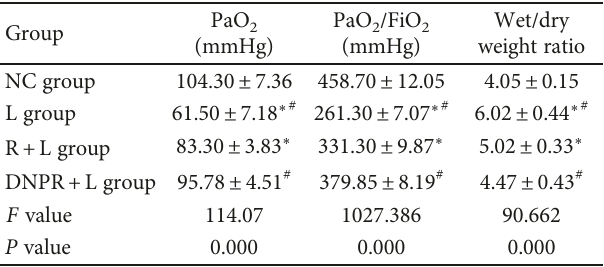
Table 1: E ff ects of LPS and LPS/CCR2 antagonist interventions on PaO , PaO /FiO , and wet/dry weight ratio in LPS-induce ALI rat 2 2 2 models ( x ± s , n = 10 ).